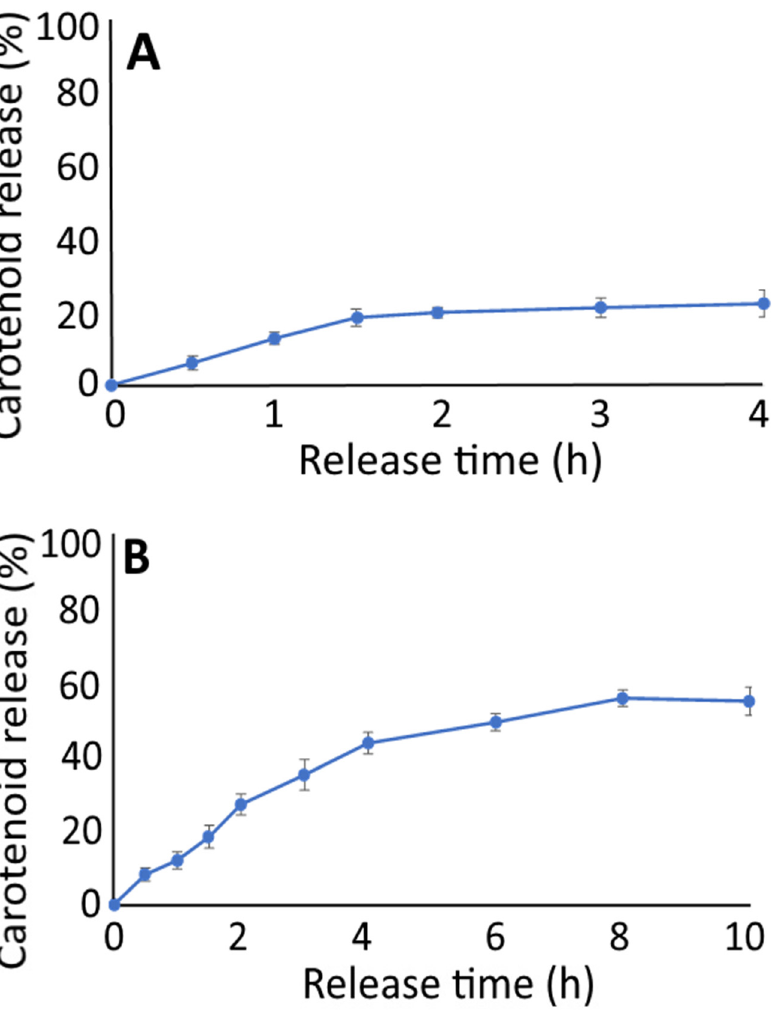
Figure 3. In vitro carotenoid release from carotenoid nanoemulsions as a function of incubation time in simulated gastric fluid for 4 h ( A ) and simulated intestinal fluid for 10 h ( B ). Results are presented as mean ± standard deviation of triplicate measurements.